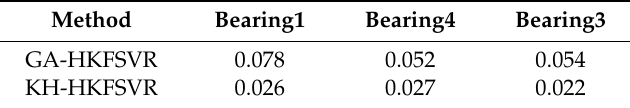
Figure 11. Performance degradation prediction of bearing 1, ( a ) is the result of HKF–SVR with parameters optimized by the GA and ( b ) is the result of HKF–SVR with parameters optimized by KH. Table 6. Prediction errors